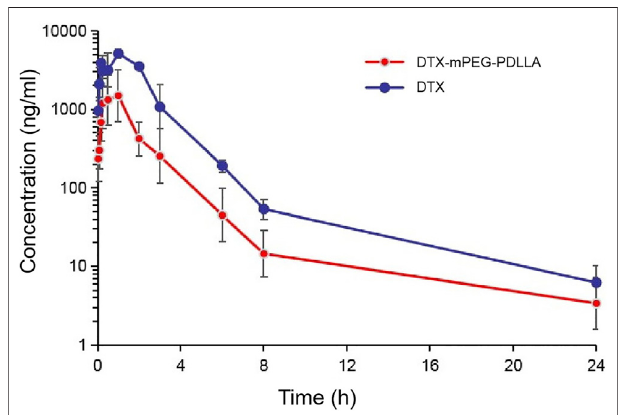
FIGURE 5 | Pharmacokinetics of DTX-mPEG-PDLLA micelles by IP administration in vivo . Plasma concentration – time curves of free DTX and DTX-mPEG-PDLLA micelles in mice via IP administration ( n = 6).